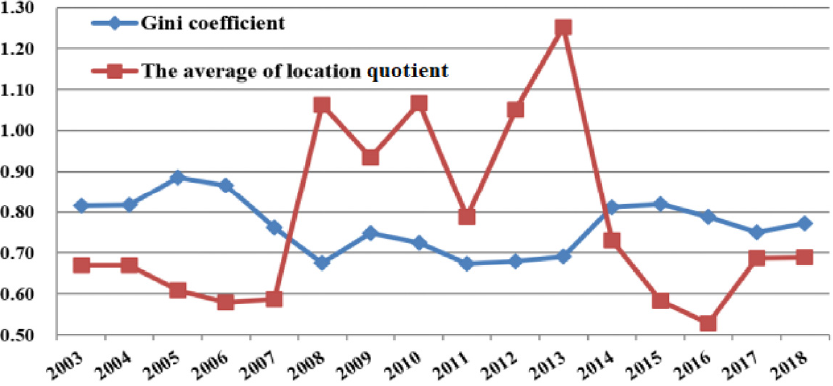
Figure 2. Gini coefficient and location quotient average trend chart venture capital in China from 2003 to 2018.